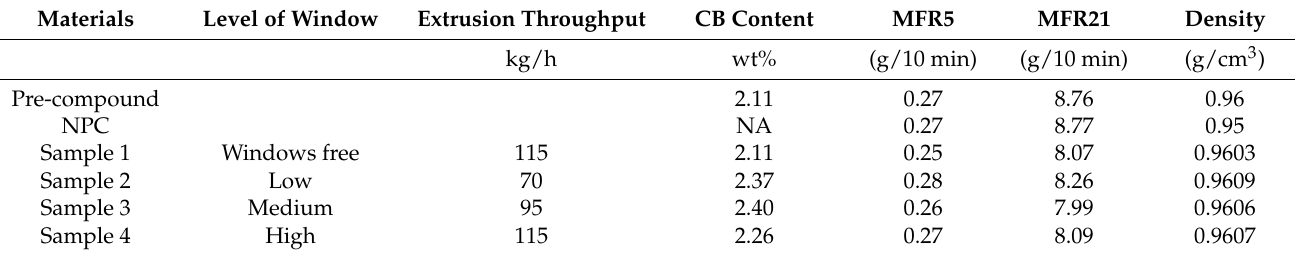
Table 1. Identification and characteristics of pipe samples.